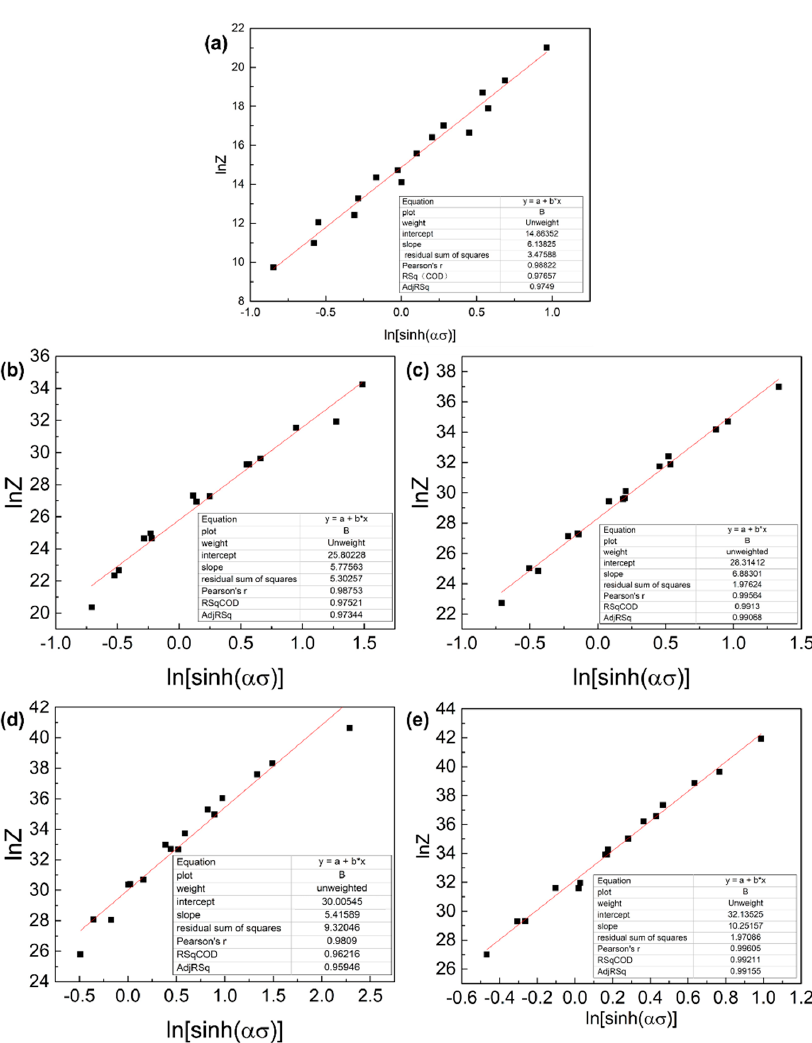
Figure 14. The relationship curve between ln Z and ln[sinh( ασ )] of each layer of alloy: ( a ) first layer, ( b ) second layer, ( c ) third layer, ( d ) fourth layer and ( e ) fifth layer. Figure 14 that the ln Z − ln[sinh( ασ )] relationship curve corresponding to each layer of material conforms to the linear law well. The slope of each straight line is its stress index n value, and its intercept is ln A . After fitting all the data, n and ln A of each part can be